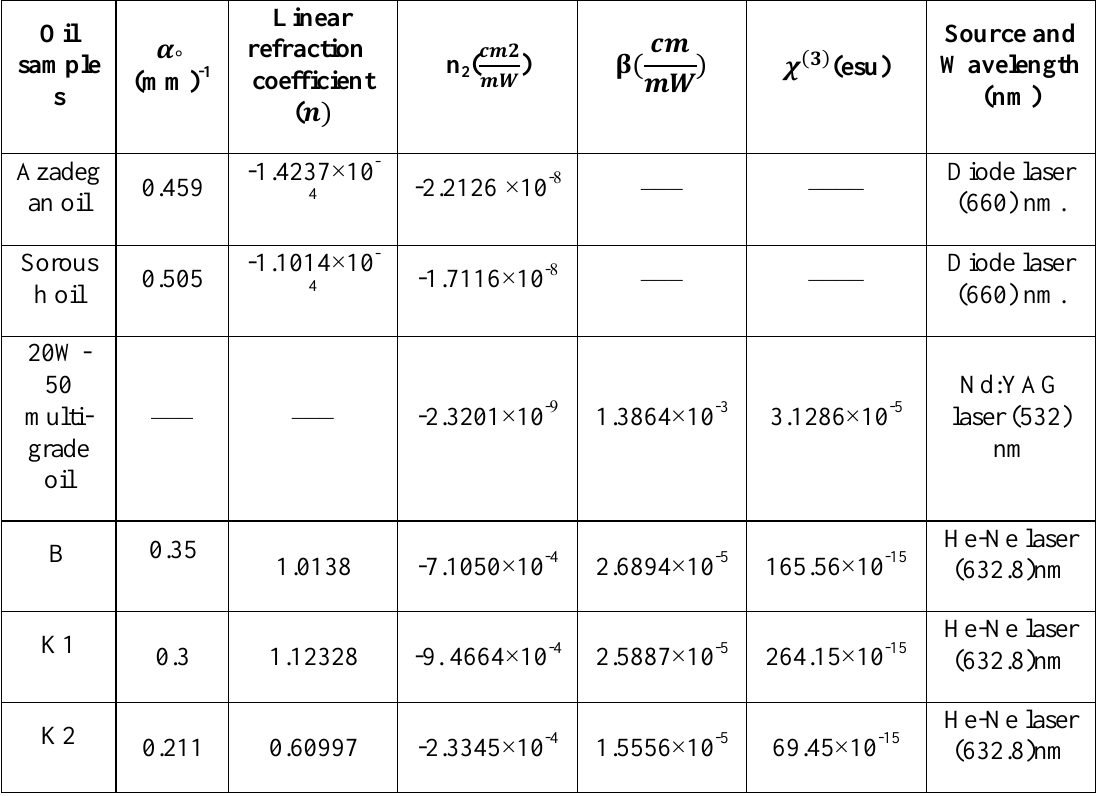
Table 6: Comparison of the obtained linear and nonlinear optical properties of Iraqi crude oil samples with values of different oil samples at different wavelengths of light